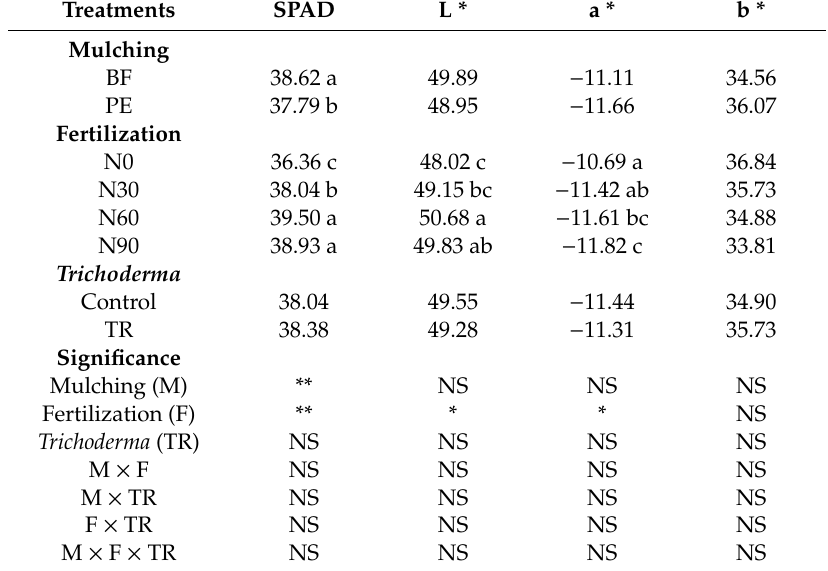
Table 2. Lettuce Soil Plant Analysis Development (SPAD) index and CIELAB color parameters (L *, a *, and b *) in relation to mulching cover films (brown photoselective film—YF and black polyethylene—PE), Trichoderma application (untreated—Control and treated—TR) and N fertilization rates (N0 = 0, N30 = 30, N60 = 60, and N90 = 90 kg ha − 1 ). [L* (lightness, ranging from 0 = black to 100 = white), a * [chroma component ranging from green ( − 60) to red ( + 60)], b * [chroma component ranging from blue ( − 60) to yellow ( + 60)]. Treatments SPAD L * a * b * Mulching